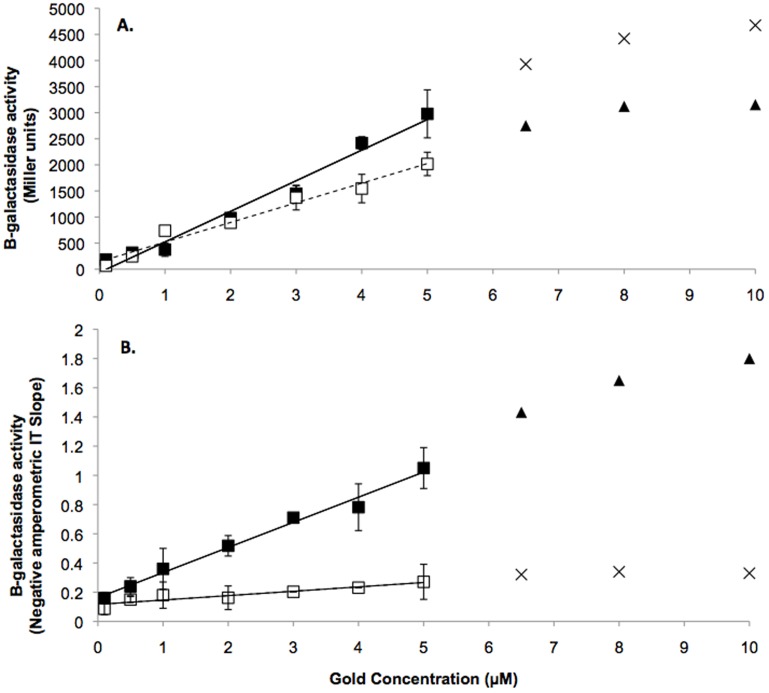
Linear relationship between Au concentrations measurable functional units.These graphs show the concentration of Au measured using the biosensor. (a) Measurements from the β-glactasidase assay, when 0.1 to 5.0 µM of Au(I) and Au(III) were used to induce the biosensor. A linear relationship could be established, outside of this range no relationship between Au concentration and β-glactasidase activity was measured, as shown in triangles for Au(I) and crosses for Au(III). (b) Electrochemistry results when 0.1 to 5.0 µM of Au(I) and Au(III) were used to induce the biosensor and a linear relationship was established, outside of this range no relationship between Au concentration and β-glactasidase activity was measured, as shown in triangles for Au(I) and crosses for Au(III). The solid box and line shows Au(I). The open box and dashed line shows Au(III). The boxes refer to the means, the capped lines show the standard deviation and the line of best fit is also shown (this shows the line formed by the equations used to determine the Au concentration measured from an unknown solution by the biosensor).